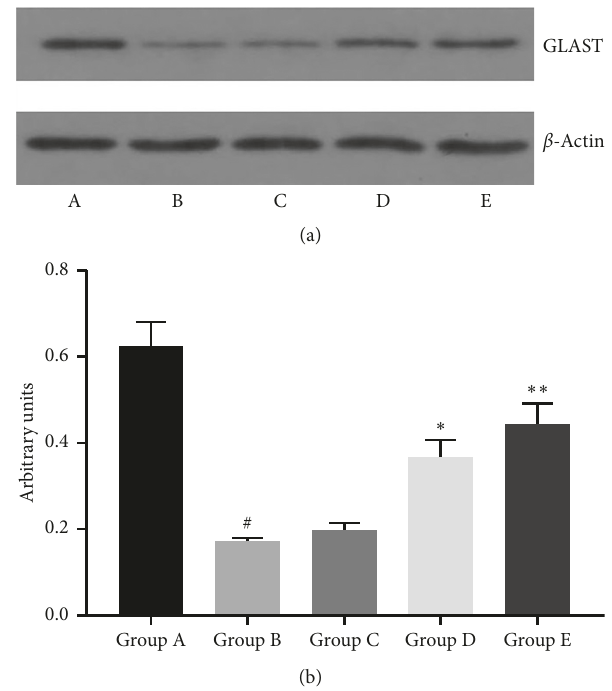
Figure 4: GLAST protein expression levels in retinal M¨uller cells. The cells were treated as described in Figure 1. (a) Representative western blot shows GLASTexpression; (b) quantification of GLAST protein expression. # P 0 . 0001, compared with Group A (0mmHg Group B (60 mmHg additional pressure). Data from one experi- < ment are shown as a representative of three studies performed under the same conditions. Group A: 0mmHg; Group